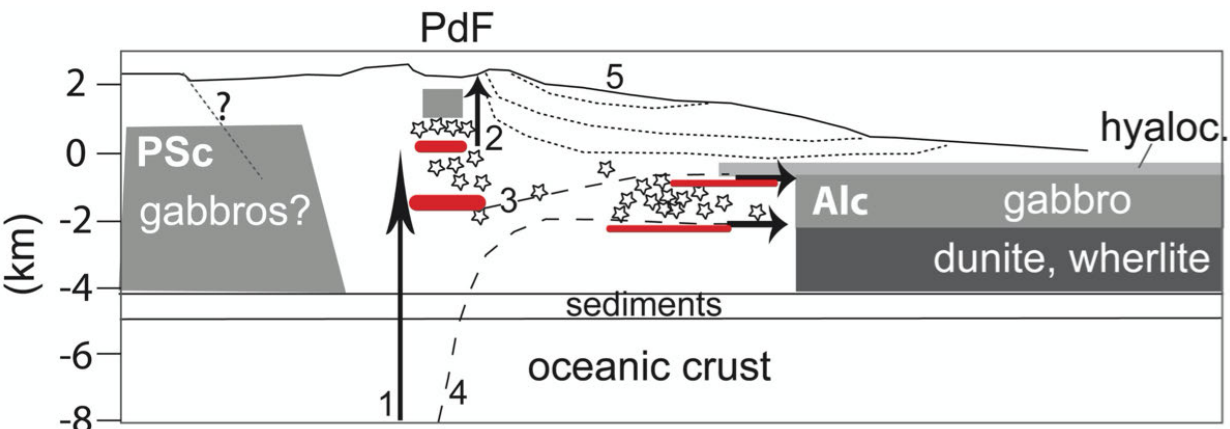
Figure 11: Synthetic structure of PdF volcano. 1: deep magma ascent path feeding the shallow magma reservoirs below the summit Dolomieu caldeira. 2: dyke injection provoking the compression (5) and sliding of the vesicular lava pile forming the eastern volcano flank [Got et al. 2013]; 3 and 4: possible sill injection paths below the eastern volcano flank feeding distal eruptions like that of 2007 [Di Muro et al. 2014]. Occurrence of hyaloclastite (hyaloc.) at the base of the lava pile together with sill intrusions might favour the seawards flank sliding. Alc: Alizé hypovol- canic complex; PSc: Plaine des Sables hypovolcanic complex; from [Gailler et al. 2009]; stars: volcano tectonic events related to recent intrusive events (2020 OVPF reports [ http://www.ipgp.fr/fr/ovpf/actualites-ovpf ]; see also Peltier et al.